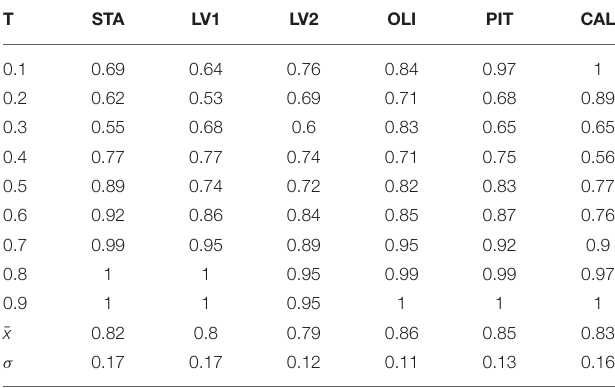
TABLE 2 | Rand Index values measuring the degree of agreement of community structures between control and ASD groups in real data.